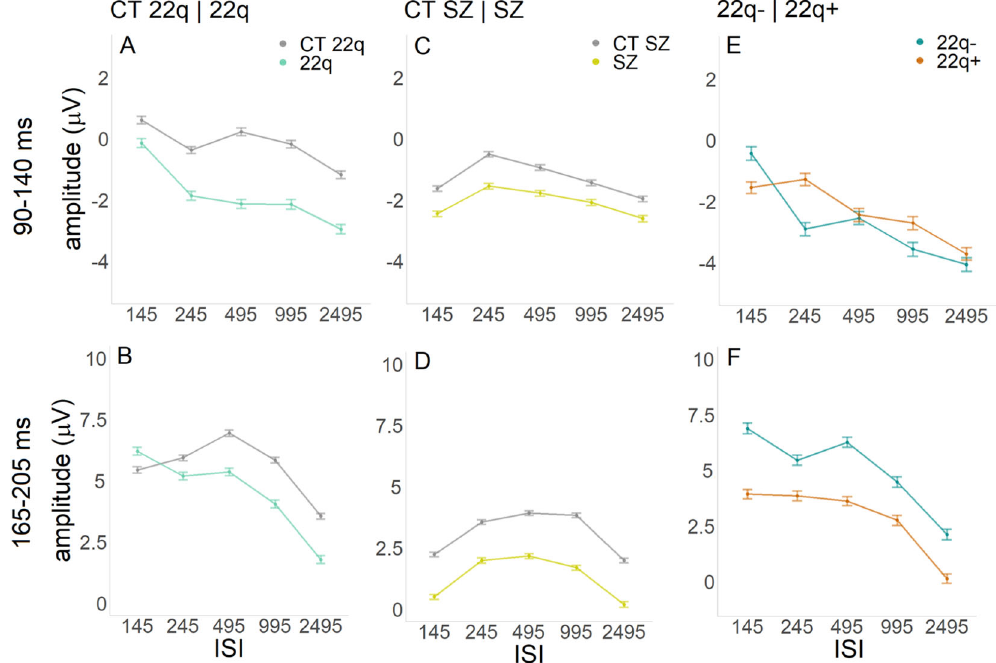
Fig. 3 Curves representing visual adaptation effects between groups. Curves representing visual adaptation effects between groups in the time windows of interest (90 – 140 ms and 165 – 205 ms). Error bars represent standard errors of the